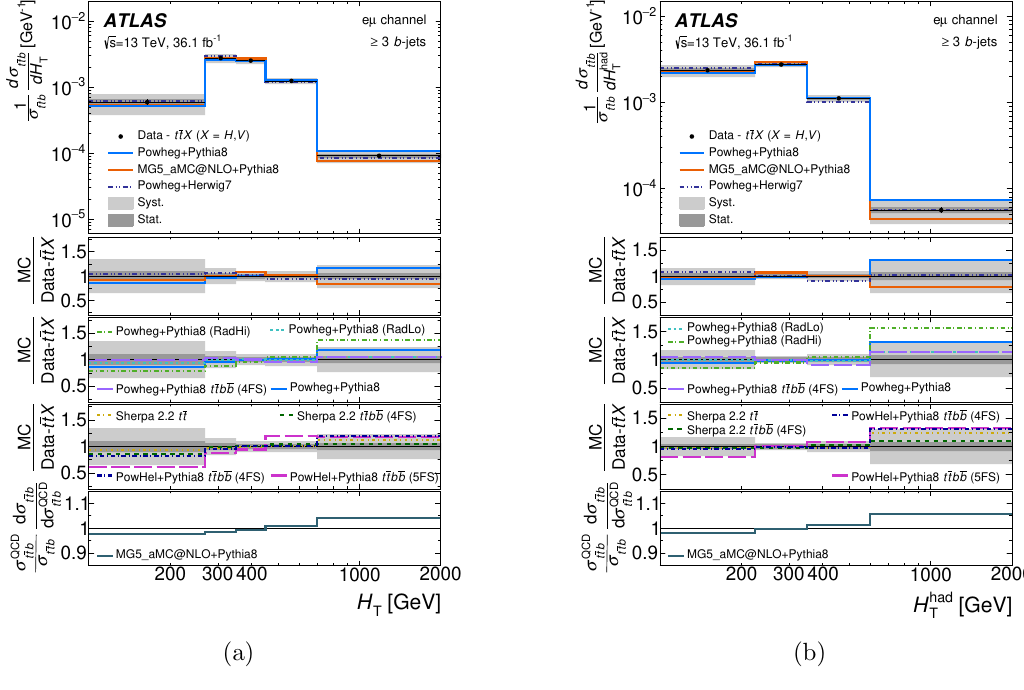
Figure 9. Relative di(cid:11)erential cross-sections as a function of (a) H T , (b) H had